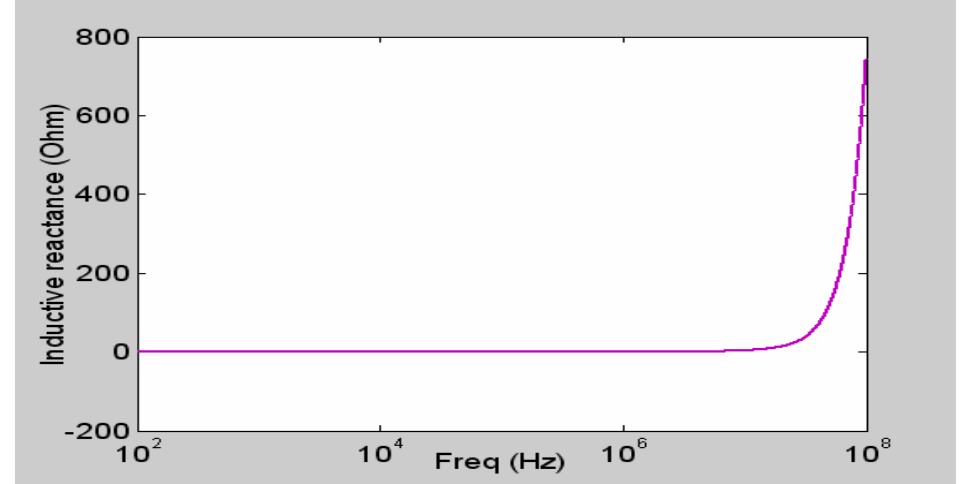
Figure 13. Variation of reactance with frequency for meander sensor.